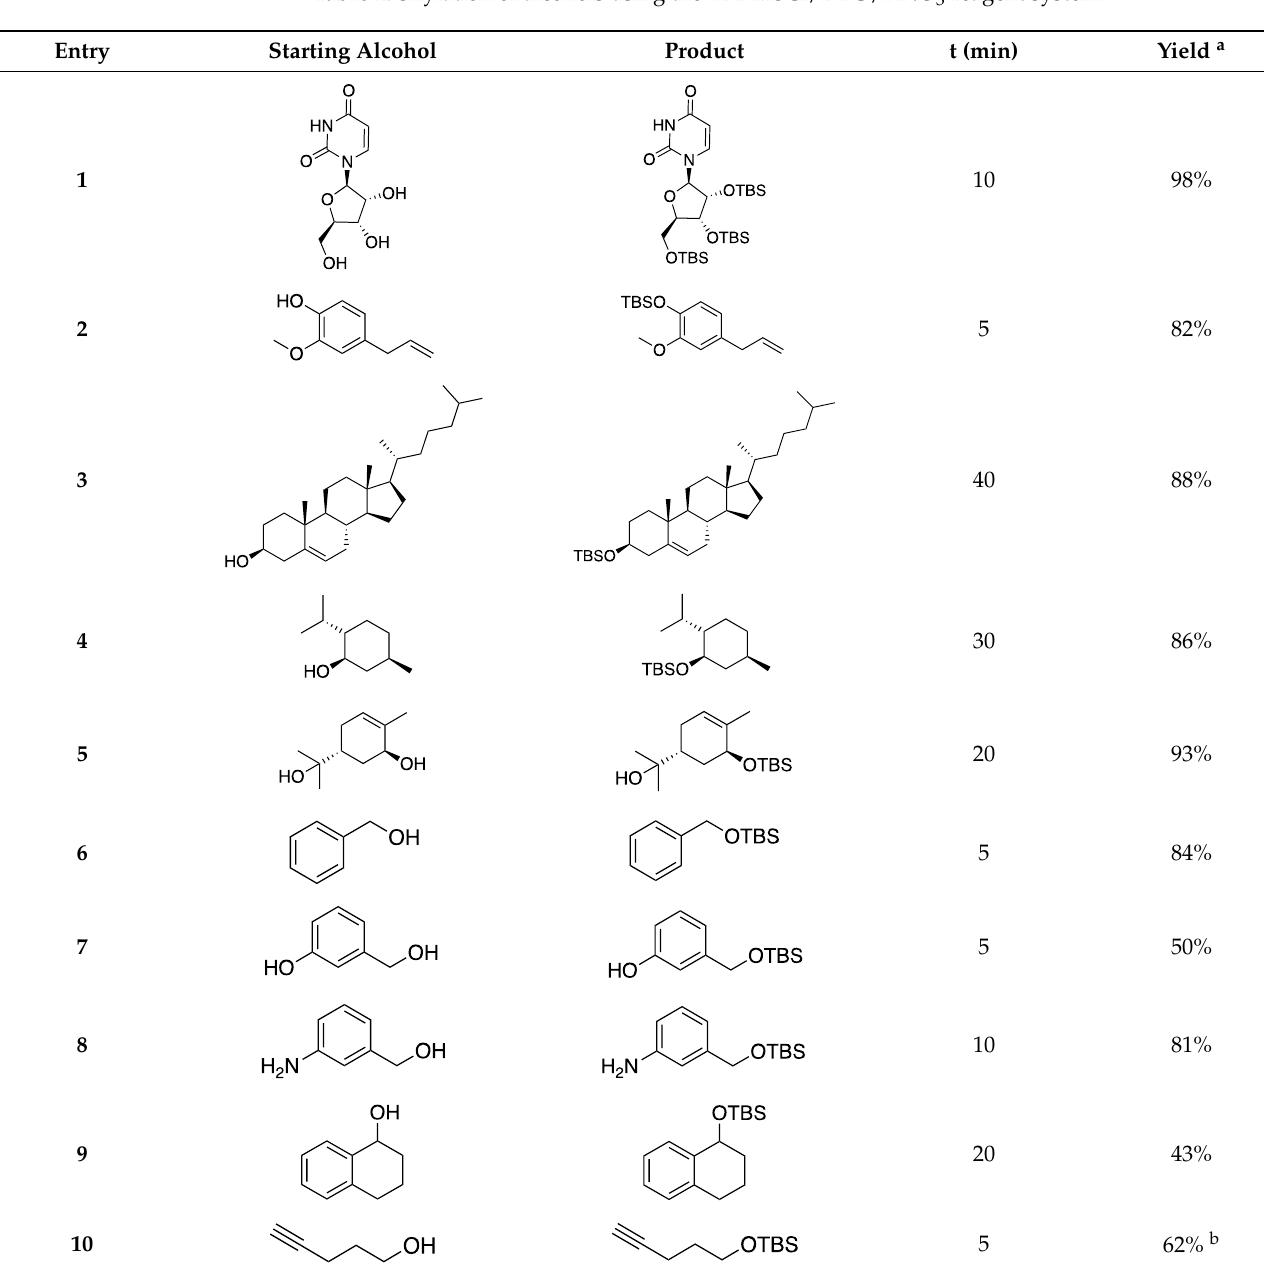
Table 2. Silylation of alcohols using the TBDMSCl/DBU/KNO 3 reagent system.